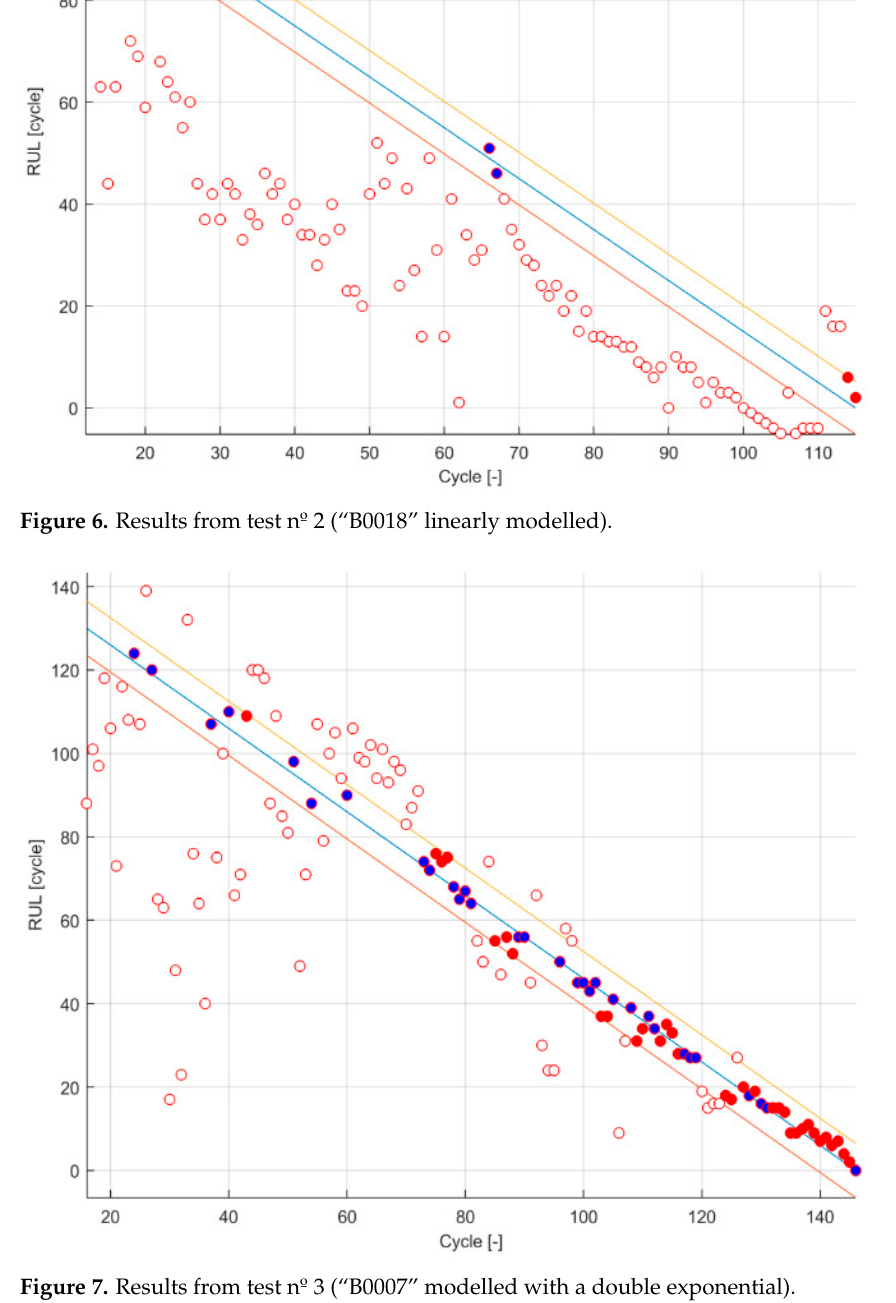
Figure 7. Results from test nº 3 (“B0007” modelled with a double exponential).